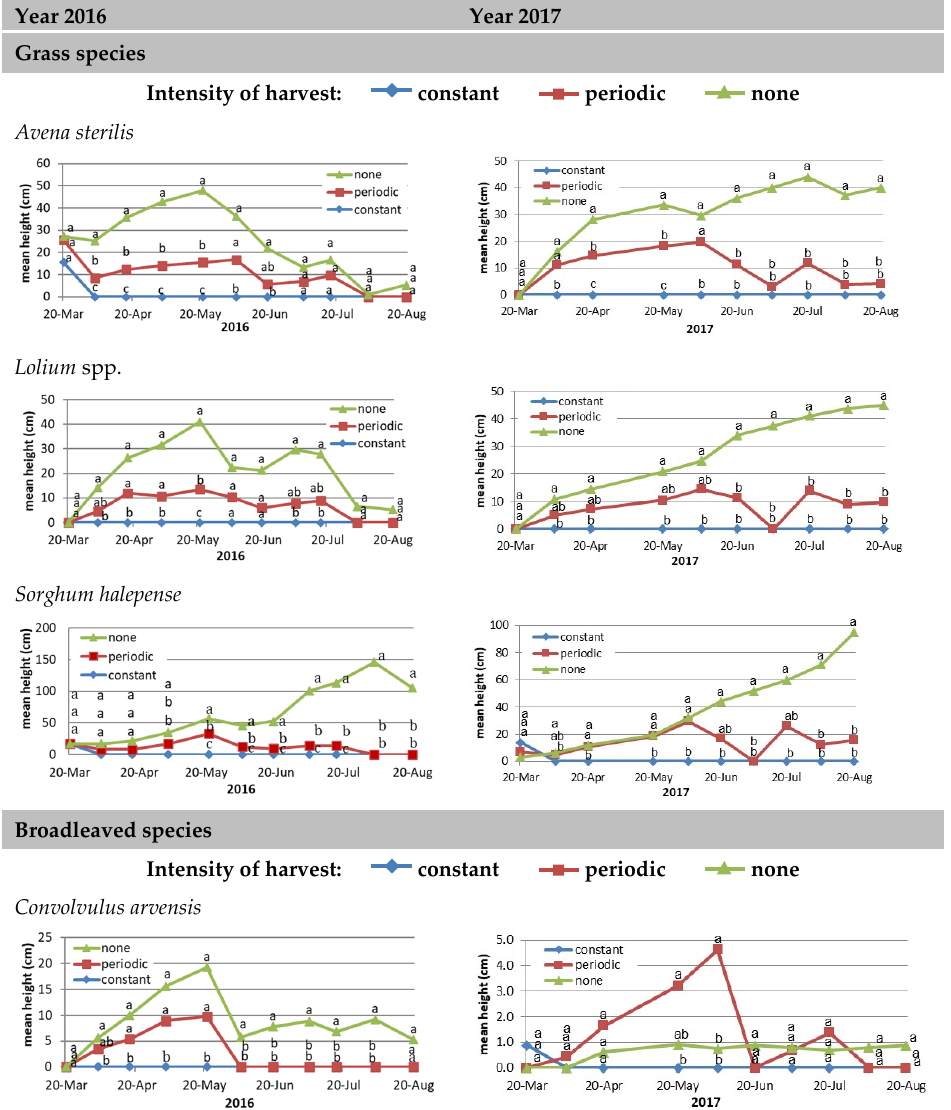
Figure 6. The mean plant height (cm) for individual species naturally growing between the rows within the vineyard under different harvest treatments (constant, periodic, or none) during 20 March–20 August in 2016 and 2017. Means in columns not followed by the same letter are significant (Tukey HSD, at p = 0.05, n = 8).